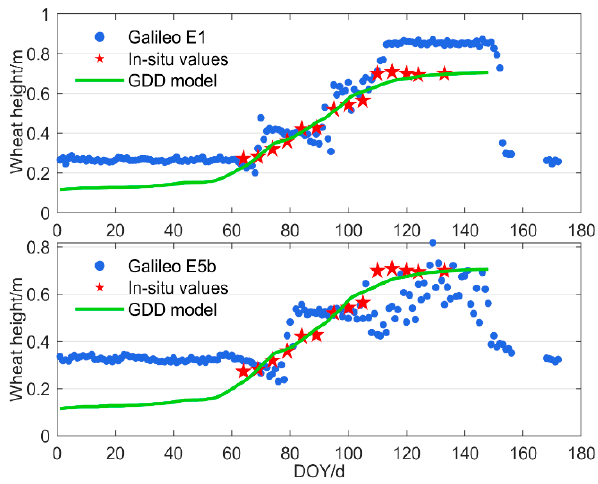
Figure 9. Wheat height retrieval with Galileo.